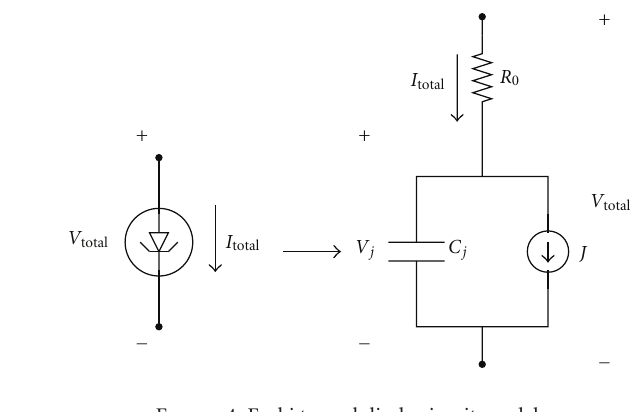
Figure 4: Esaki tunnel diode circuit model.